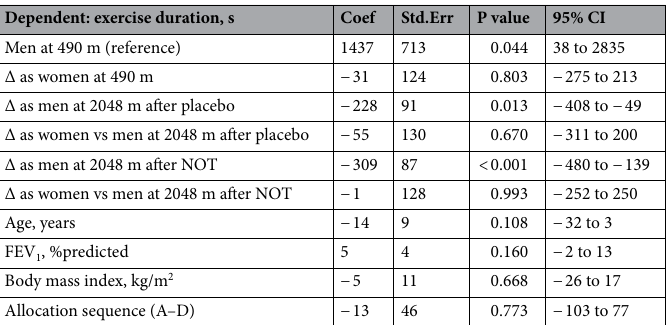
˙ V E ); Panel ( H ) ventilatory ˙ V ˙ V CO 2 ); E /